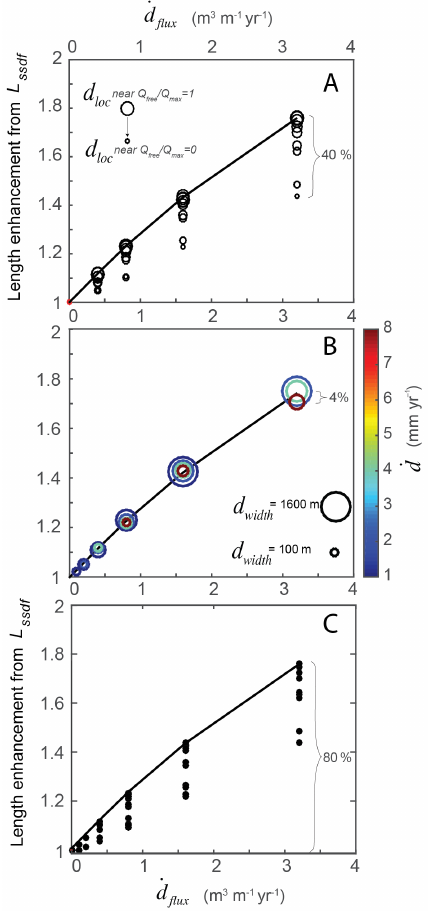
Figure 9. Dependence of steady state glacier length on debris deliv- ery to the glacier. Glacier lengths are normalized by the steady state debris free glacier length, L ssdf . Bold lines connect results with the same location of debris input, with d loc fixed at 42%. (a) Steady state glacier lengths from simulations in which debris flux, ˙ d flux and d loc are varied, and d width is fixed at 400m. Vertical columns of points represent simulations in which debris location is varied and debris flux is held constant. The same results are presented in Fig. 7. (b) Steady state glacier lengths from simulations in which ˙ d ˙ d are varied while d width and loc remains fixed at 42%. The diam- eter of circle represents width of the debris deposition zone, its cen- ter representing the steady state glacier length. Clusters of circles are simulations with the same debris flux. (c) Steady state glacier length from all simulations in (a) and (b) in which, d width , ˙ d , and d loc are varied. The maximum effect of varying ˙ d flux on steady state glacier length is 80%.